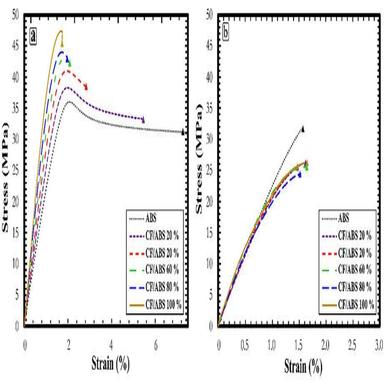
Stress and strain graph of neat ABS and CF/ABS with varying concentrations (by volume %) of each filament, (a) specimen printed on XY plane, (b) specimen printed on XZ plane.